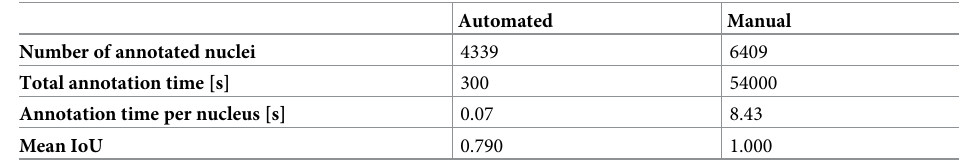
Table 1. Performance of automatically and manually annotated nuclei. Automated